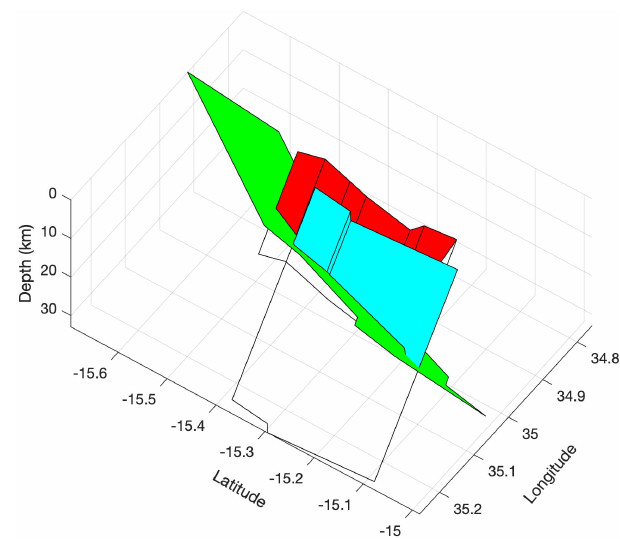
Figure A2. Examples of faults in the MSSM that are projected to intersect and where the across-strike distance at the surface is sufficient ( > 6km) so that they are interpreted to represent distinct sources. In this case, the longer Chingale Step fault (green) is in- terpreted to have cut off the shorter Mlungusi (red) and Liwawadzi (cyan) faults, so that their geometry does not extend below the in- tersection, as indicated by transparent polygons. The revised cut-off area of these faults is then used in the earthquake magnitude and single event displacement scaling relationships (Eqs. 3 and 4).